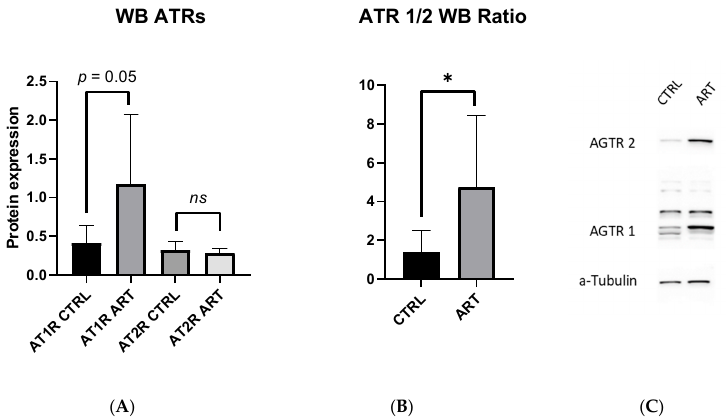
Figure 2. ( A ) AT1R and AT2R protein expression and ( B ) AT1R/AT2R ratio in aorta measured by Western blotting ( n ≥ 7/group). ( C ) A representative western blot image. Values are mean ± SE. * p < 0.05, ART vs. Ctrl. ns = not significant.